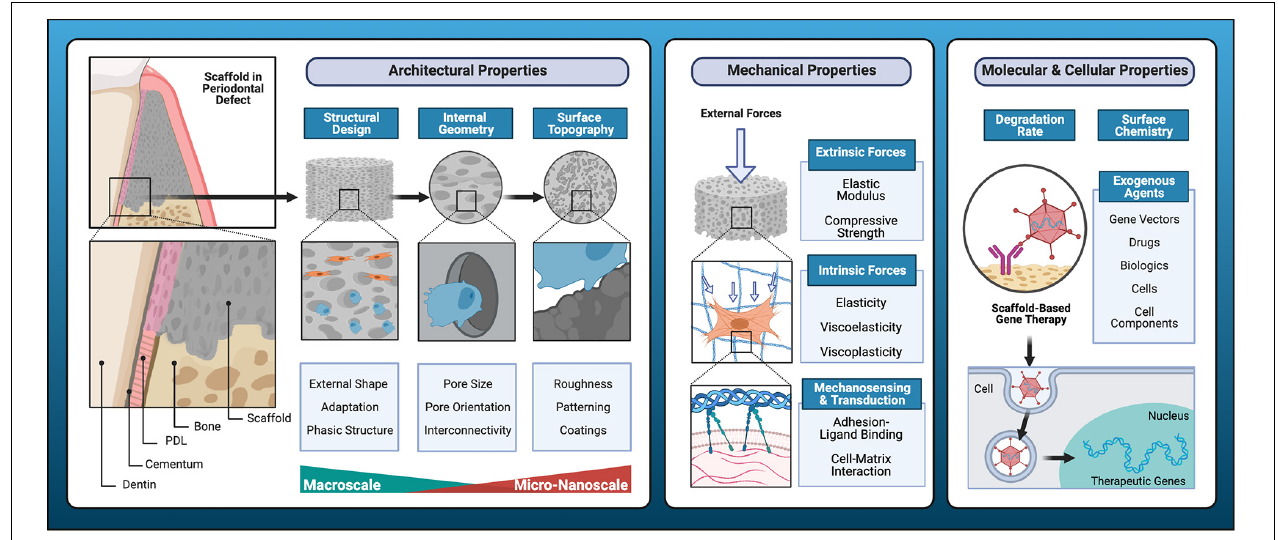
FIGURE 2 | Key determinants of cell-scaffold interactions. Resorbable scaffolds for the regeneration of functional dental, oral, and craniofacial tissues require tailored, biomimetic features that consider structural design, internal geometry, and surface topography to promote cell-scaffold interactions. Additive manufacturing facilitates optimization of physical properties of scaffold substrates to promote overall mechanical performance and fine tune biomechanical regulation of cell behavior. Intrinsic material properties such as degradation rate and surface chemistry are key biochemical considerations, and various exogenous agents with bioactive properties may be incorporated for scaffold functionalization to further enhance regenerative